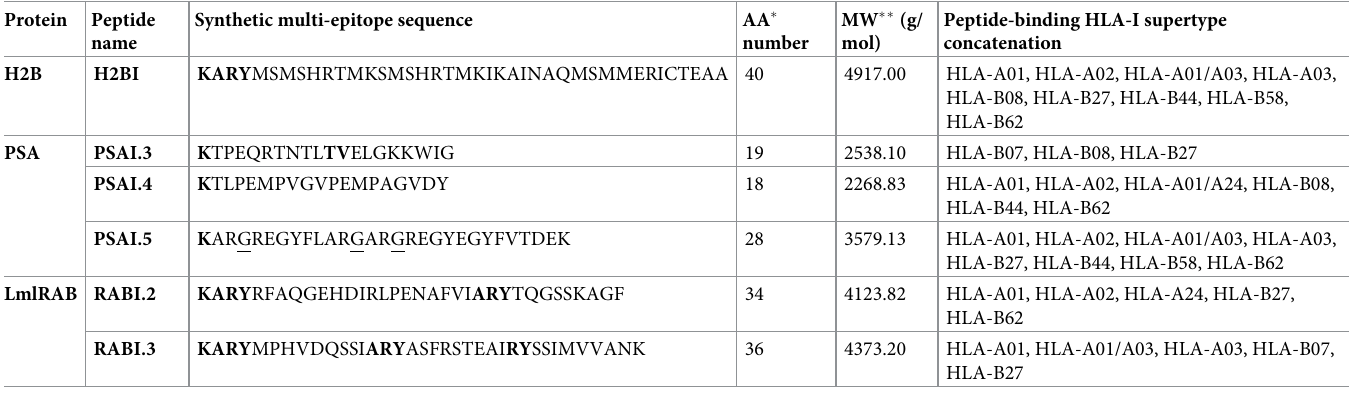
Table 4. Characteristics of in silico predicted multi-epitope peptides. Protein Peptide